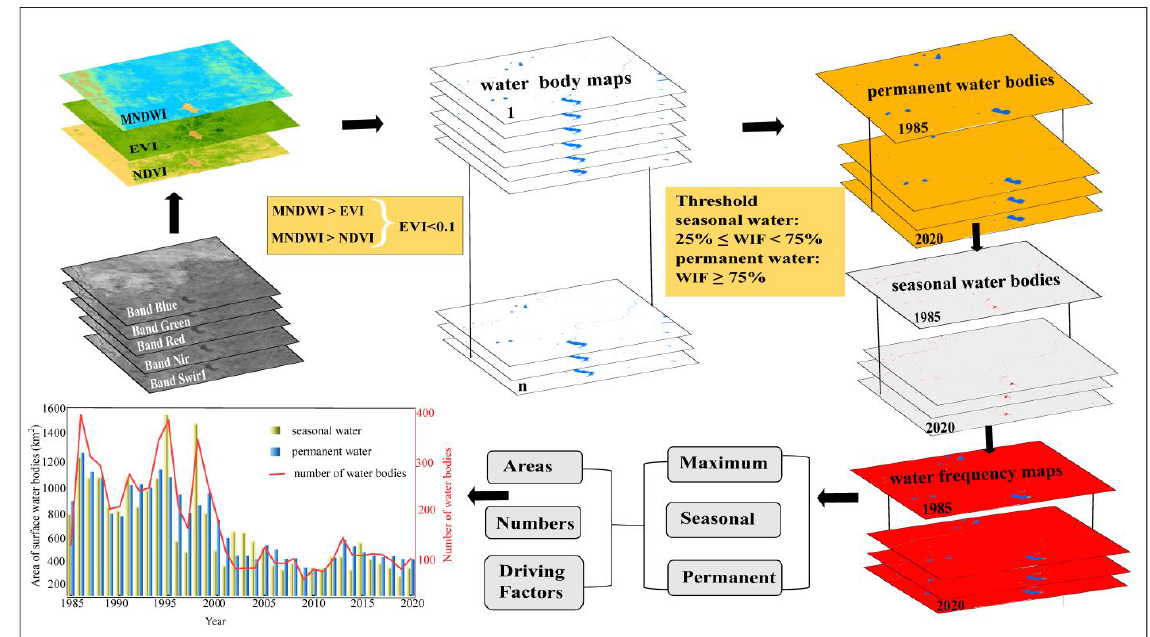
Figure 3. Flowchart of the study.